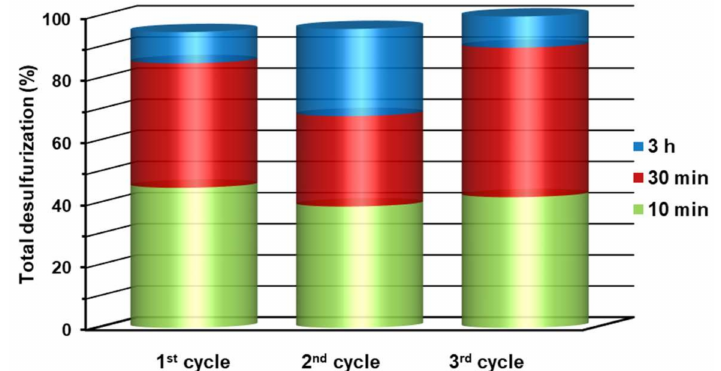
Figure 7. Desulfurization data of a multicomponent model diesel for three consecutive cycles using the ECODS system with PMo 12 @MOF at 50 ◦